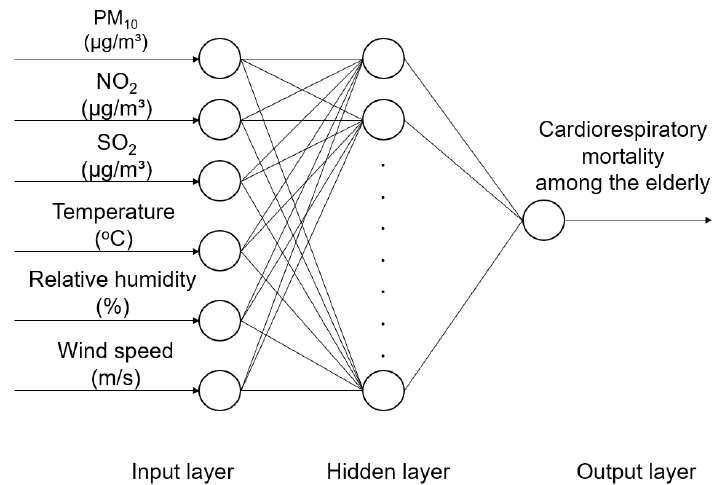
Figure 2. Schematic representation of ANN model with one hidden layer.